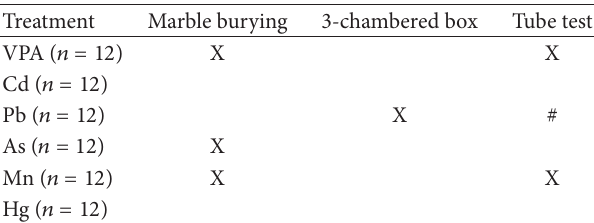
Table 2: Metatable for behavioral studies. Treatment Marble burying 3-chambered